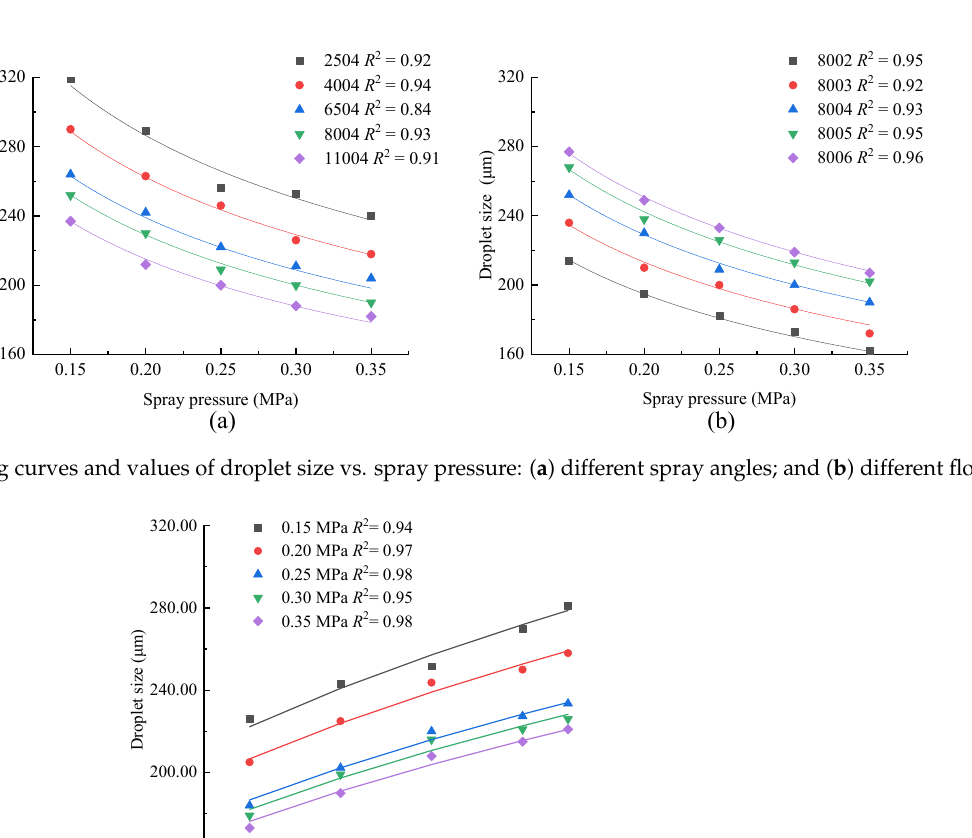
9 of 18 Figure 6. Fitting curves and values of droplet size vs. spray pressure: ( a ) different spray angles; and ( b ) different flow rates.